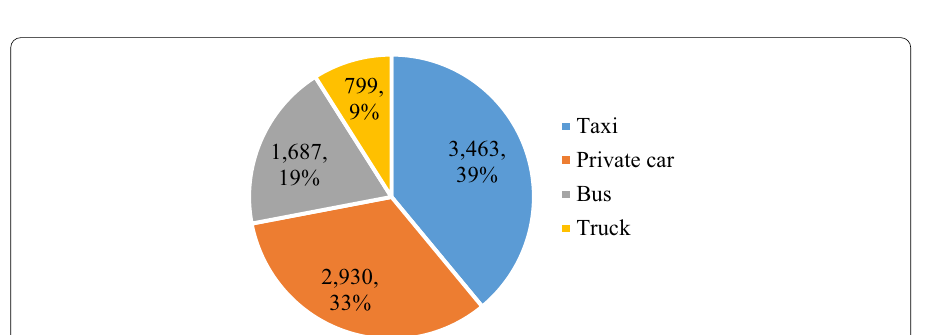
Fig. 4 The annual traffic volume of different motor